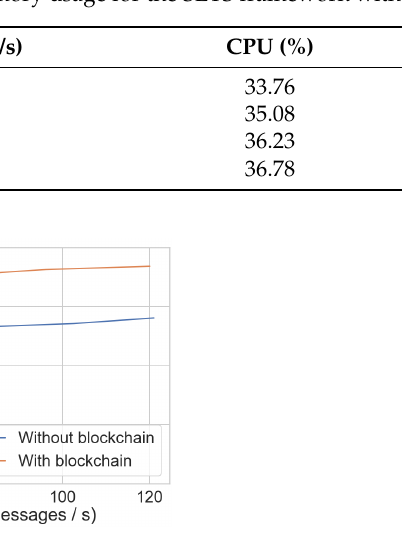
Figure 9. CPU usage comparison depending on the send